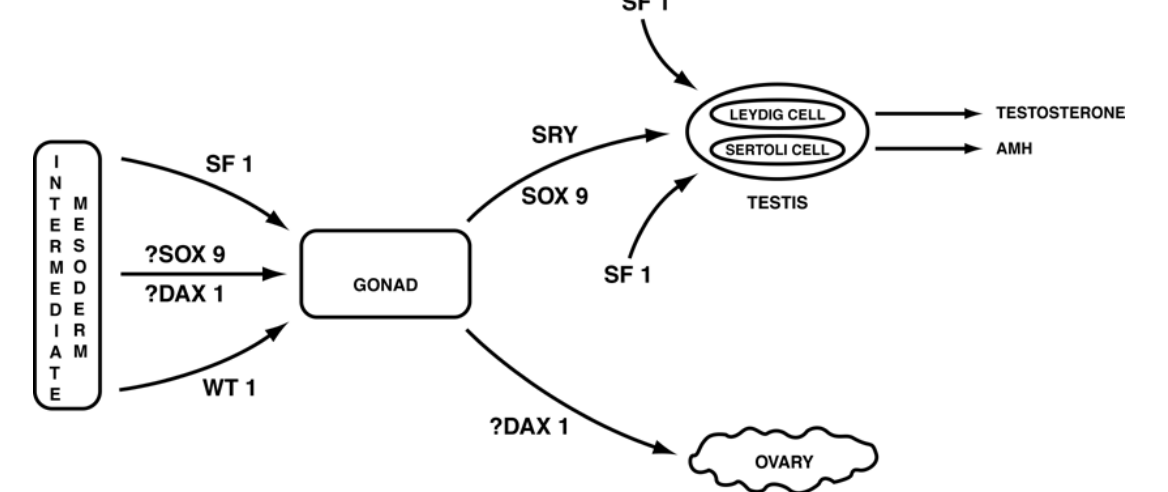
FIGURE 1. Proposed pathway of gonadal development and